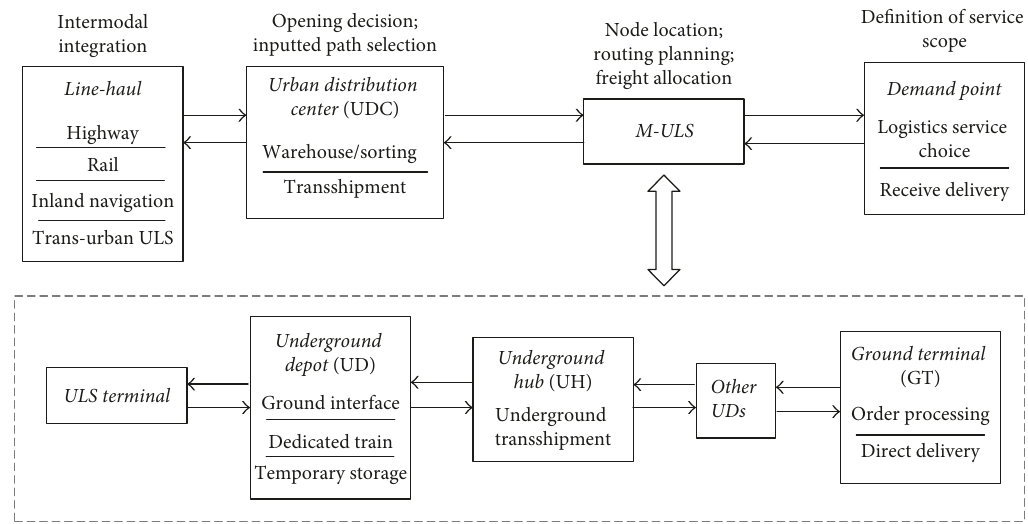
Figure 1: Operational modules and issues of M-ULS-integrated urban